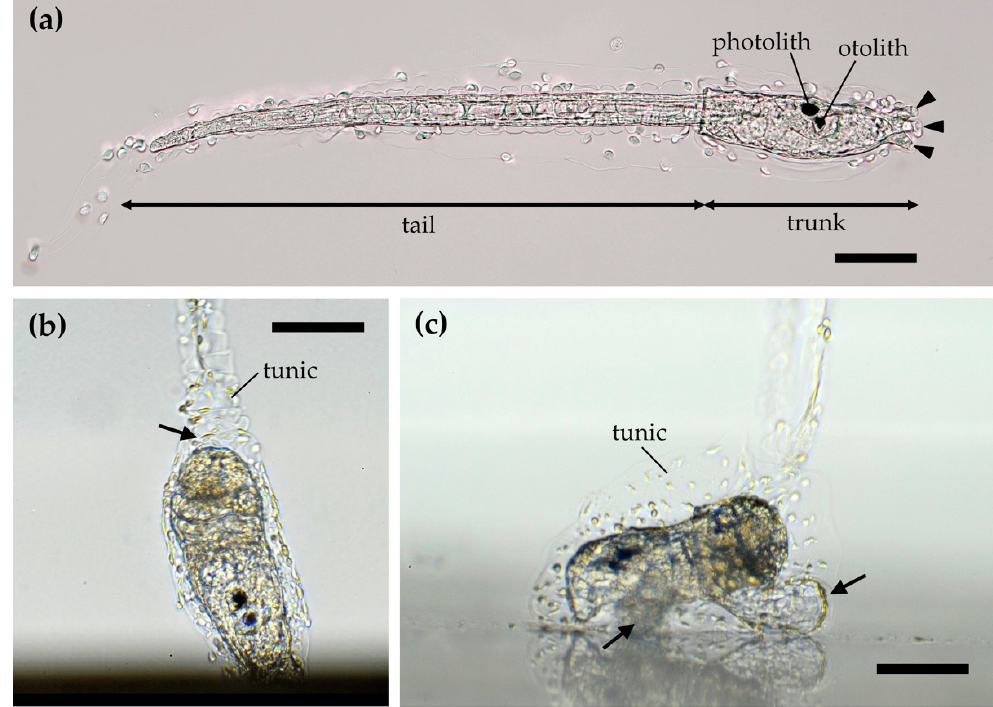
Figure 1. Swimming larva ( a ) and the settlement ( b , c ) of Phallusia philippinensis (lateral view). ( a ) A swimming larva with a tail. Three adhesive organs are present at the apical end of the trunk (arrowheads). ( b ) A larva adhering to the substrate with the adhesive organs. The tail is absorbed into the trunk (arrow). ( c ) A metamorphosing larva extending epidermal ampullae onto the substrate (arrows). All scale bars indicate 100 µm.